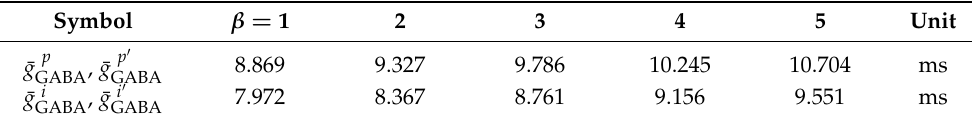
Table 5. Average GABAergic conductance values for the two-cortical-column model where = 6. ¯ g p , i , p (cid:48) , i (cid:48) AMPA Symbol β = 1 2